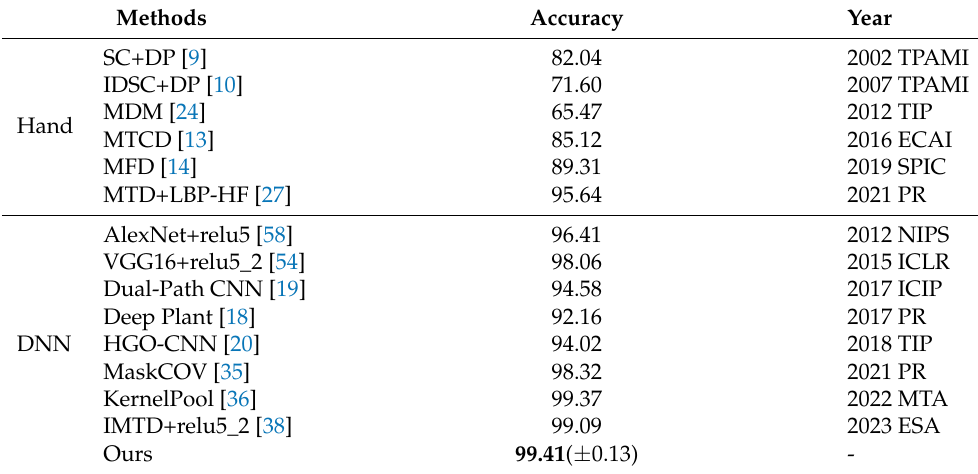
Table 5. Classification accuracy (%) comparison on MEW2012 dataset with identical settings.